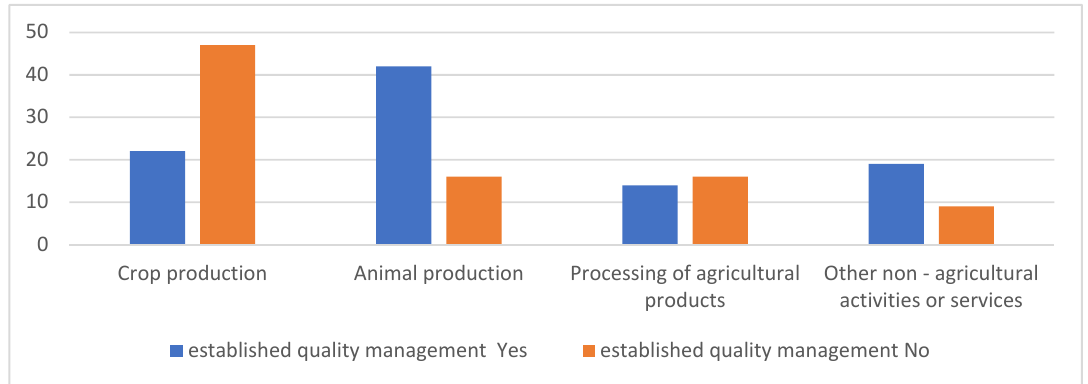
Figure 3. Application of the quality management system according to the branch of production, in percentage (Source: own research).